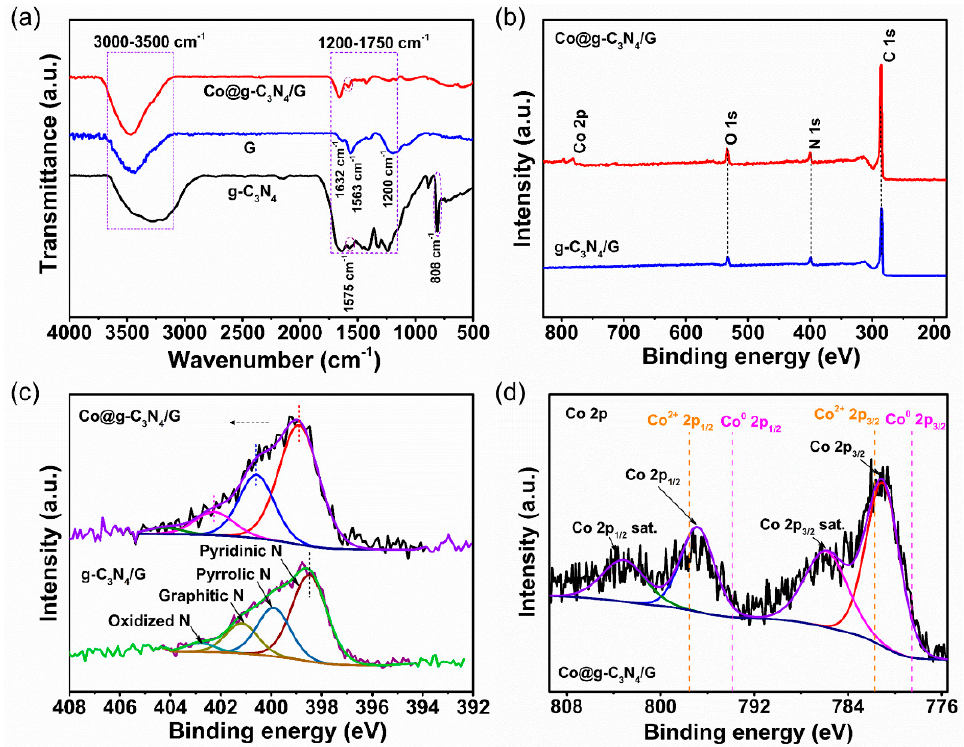
Figure 3. ( a ) FT − IR and ( b ) XPS survey spectra of the prepared samples. ( c ) Comparisons of N 1s high − resolution XPS spectra in Co@g-C3N4/G and g-C3N4/G samples. ( d ) Co 2p high − resolution XPS spectra in the Co@g-C3N4/G heterostructure.